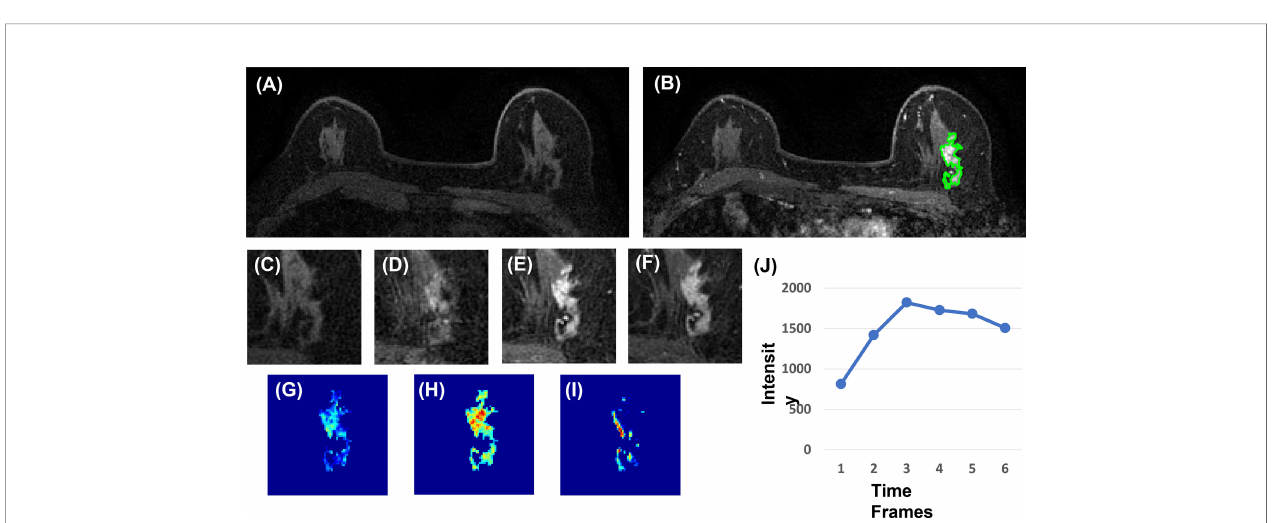
FIGURE 3 | A 63-year-old patient with invasive ductal cancer (IDC). (A) F1 pre-contrast image. (B) F2 post-contrast image. (C) F1 pre-contrast. (D) F2 post- contrast. (E) F3 post-contrast. (F) The last F6 post-contrast image, showing wash-out DCE pattern with decreased intensity after reaching maximum in F3. (G) The wash-in signal enhancement map F2 – F1. (H) The maximum F3 – F1 signal enhancement map. (I) The wash-out F6 – F3 map. (J) The DCE time course shows a typical wash-out pattern, reaching maximum in F3, followed by decreased intensity from F4 to